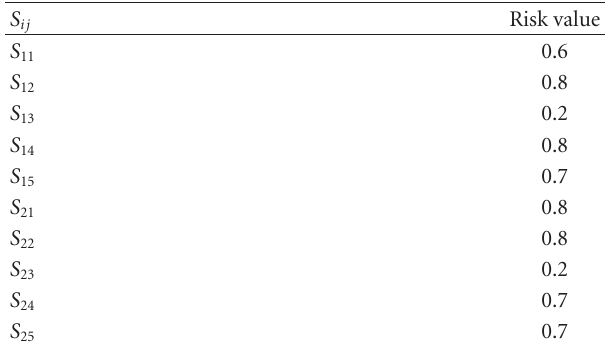
Table 14: The considered risk factors for s 1 and s 2 .